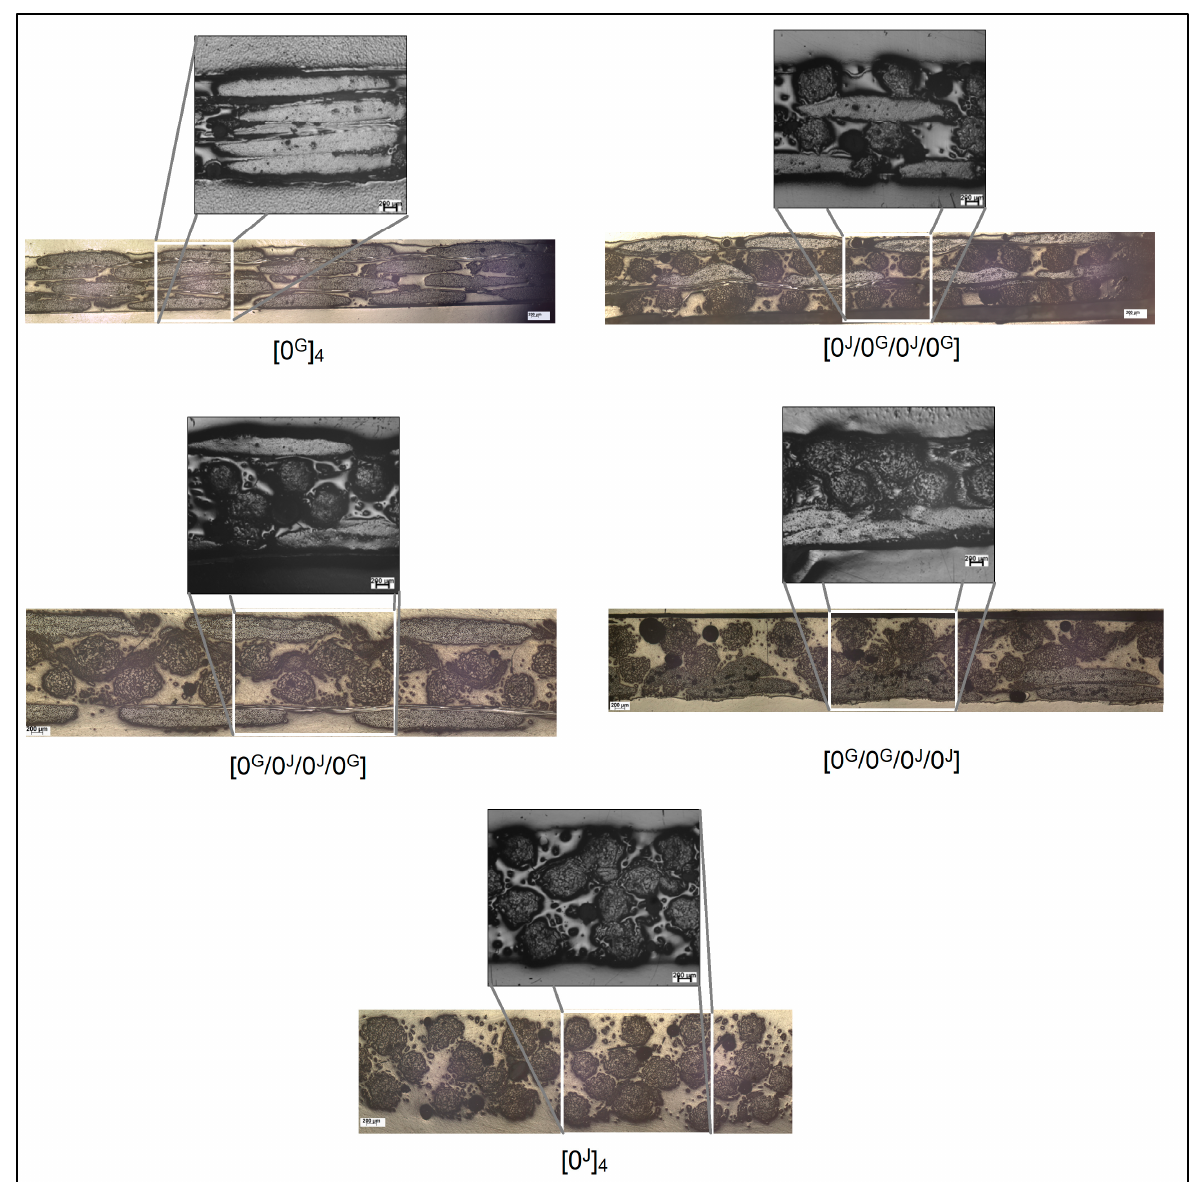
Figure 4. Panoramic and zoom-in images from optical microscopy for the laminates. Table 2. Thickness of each layer of the laminates, in